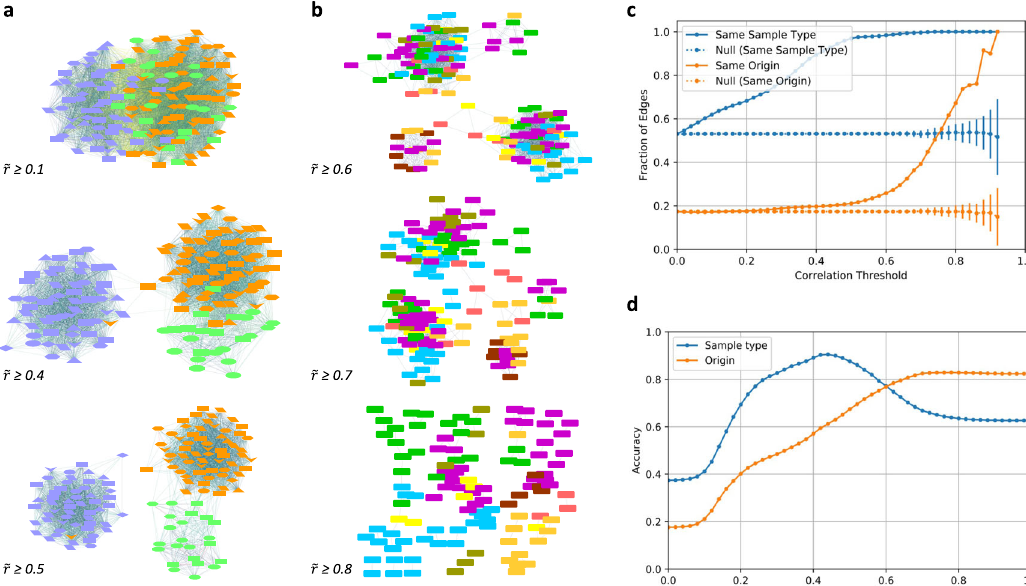
Fig. 3 Network transformation as a function of varying correlation threshold. ( a ) Processing-stage modules: modules of LC-MS samples belonging to the same cocoa processing-stage in a typical cocoa processing pipeline. ( ~ r (cid:1) 0 : 1 ) Mild separation of unfermented, fermented and liquor cluster; ( ~ r (cid:1) 0 : 4 ) modular structure improves; ( ~ r (cid:1) 0 : 5 ) groups of unfermented, fermented and liquor samples are clearly separated. The fi gure follows same legend as of Fig. 2b. See Supplementary Fig. 2 for a detailed version of networks and for a movie of evolving network as the correlation threshold is progressively increased. ( b ) Country modules: correlation thresholds of 0.6, 0.7 and 0.8. Several modules with nodes belonging to the same country of origin are revealed. For a quick and better comprehension, and unlike the legend of earlier correlation networks, in this fi gure, different countries are represented through a different color. (For corresponding node-labeled network see Supplementary Fig. 4. The networks with same thresholds but with previous node color/shape scheme is given in Supplementary Fig. 5) ( c ) Connected nodes ’ similarity. The sample-type similarity (blue line) starts to increase linearly right from smaller correlation threshold values, reaches close to 1 around a correlation threshold value of 0.5. The origin similarity remains constant for a long range of correlation threshold (0, 0.50) and then increases rapidly. The dashed lines and error bars show corresponding similarities and standard deviation, respectively (see Similarity of nodes connected by an edge), as expected from an ensemble of control networks. ( d ) Accuracy of links in thresholded correlation networks, or closeness of a thresholded correlation network to expected ideal network. As the correlation threshold increases the threshold networks become closer to their ideal counterparts. (For an explanation of ‘ accuracy ’ through a toy-example, see Supplementary Fig. 10) In regions of lower correlation threshold, the thresholded networks describe the sample type character of the network more than the origin type character. In regions of higher correlation threshold, opposite is true and the thresholded networks are closer in their character to the origin attribute of LC-MS samples. This is coherent with the network pictures at various threshold seen in earlier fi